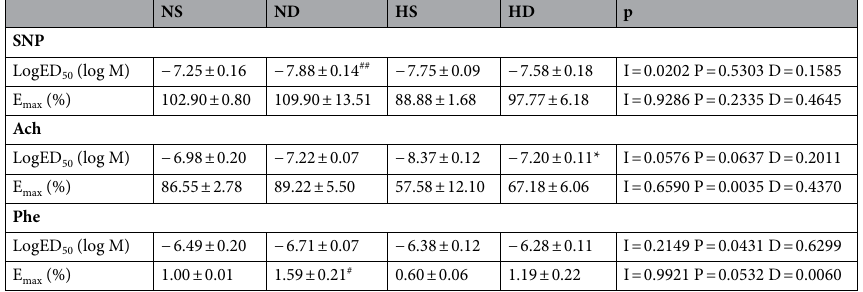
Table 1. Half-maximal dose (logED 50 ) and maximal response (E max ) to sodium nitroprusside (SNP), acetylcholine (Ach) and phenylephrine (Phe). Values are mean ± SEM. Data were analyzed by two-way ANOVA followed by Fisher post hoc test. Normotensive sham (NS); denervated normotensive (ND); SHR sham (HS); denervated SHR (HS). # p < 0.05, ##p < 0.01 vs . NS; *p < 0.05 vs. HS. ANOVA: Interaction factor (I); blood pressure background factor (P); denervation factor (D).